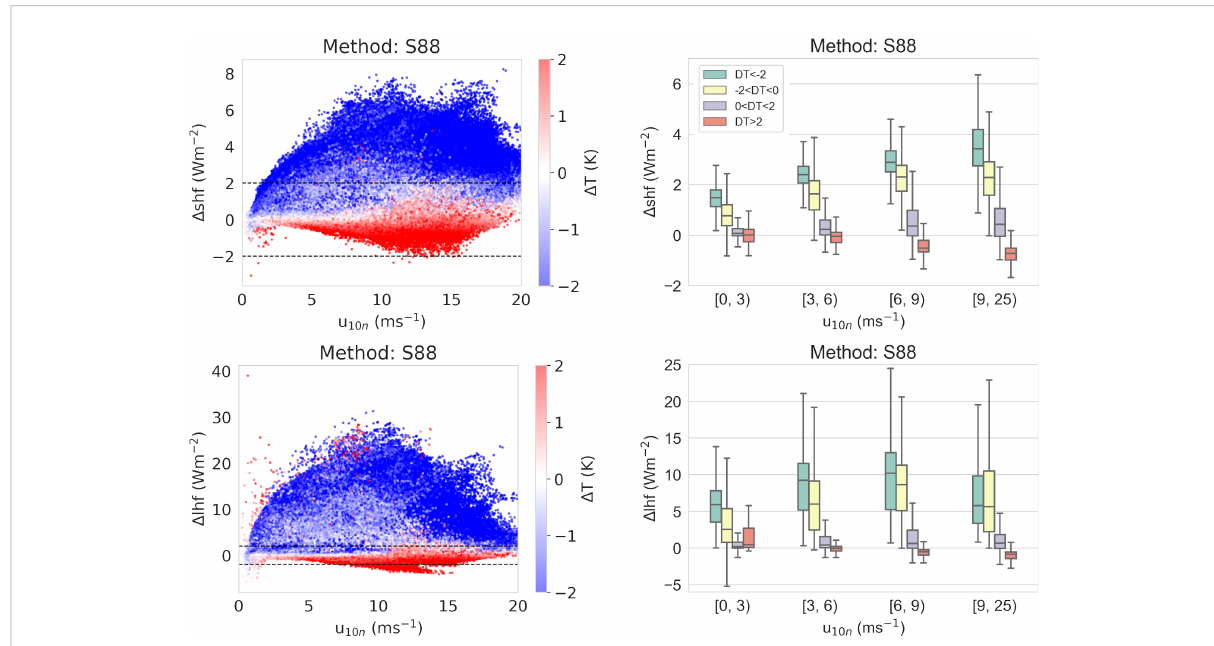
FIGURE 5 Left hand column: scatterplots of the effect of the cool skin adjustment on shf (top) and lhf (bottom) estimates for S88 bulk parameterization ( D X=X skinOn -X skinOff ), relative to u 10n and D T. The signi fi cance limits (Table 2) for the heat fl uxes are denoted by the horizontal dashed lines. Right hand column: the corresponding box-plots of heat fl uxes in relation to different ranges of u 10n and D T, showing the median (middle line), the inter-quartile range (25 – 75%, box), and the outer range (whiskers, < 25% and >